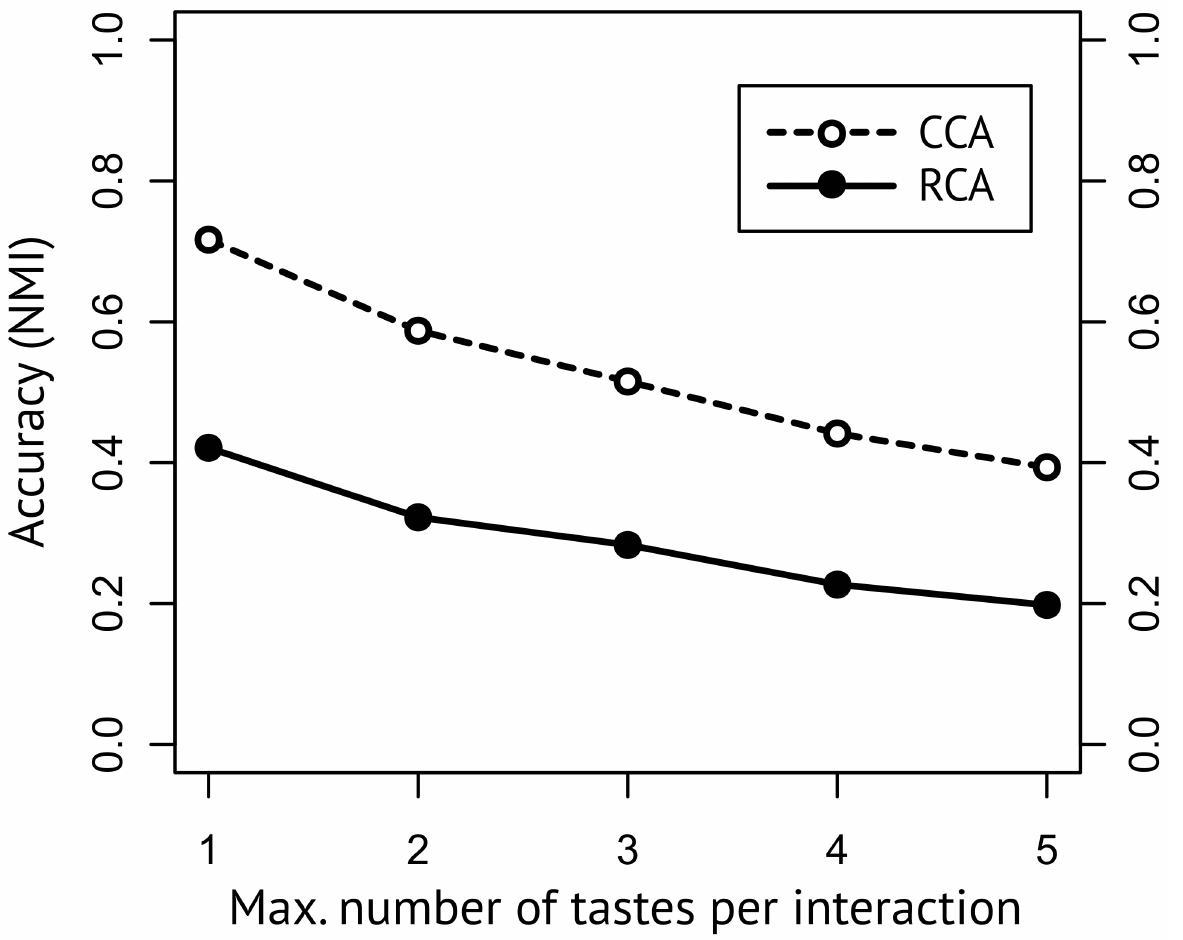
Figure 9: Accuracy for 2,000 simulations with multiway